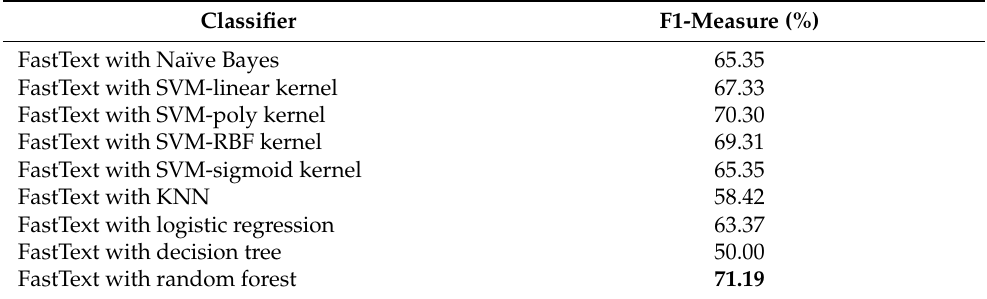
Table 10. Effect of bilingual preprocessing using stop-word elimination (SW) and lemmatizing (LEM) for the case study.